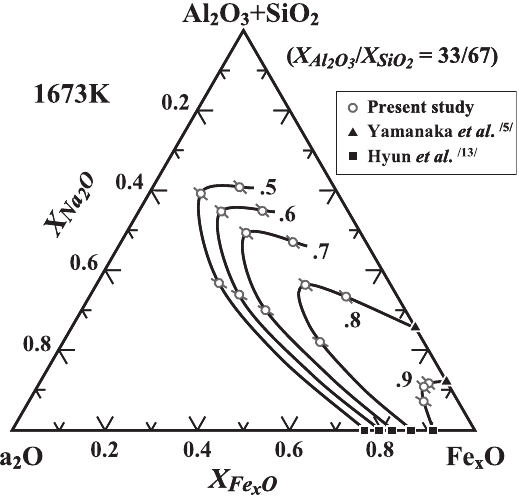
O /SiO mole ratio of 33/67 at 1673 K. 2 3 2